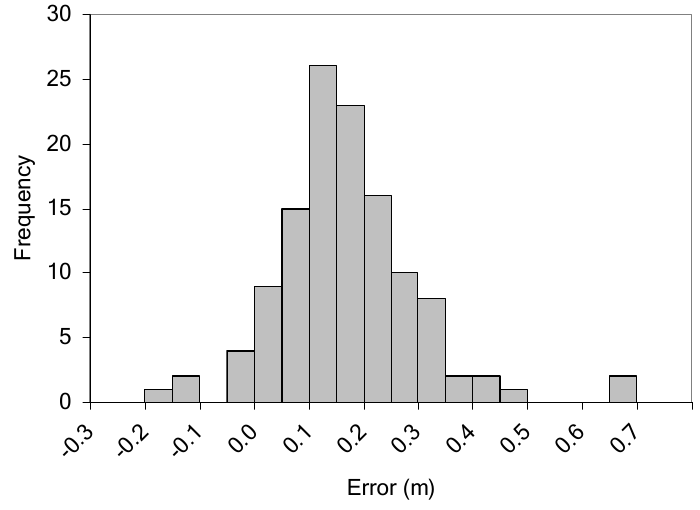
Figure 7. Distribution of LiDAR DEM error computed as DEM elevation—survey elevation at 126 road centerline locations.